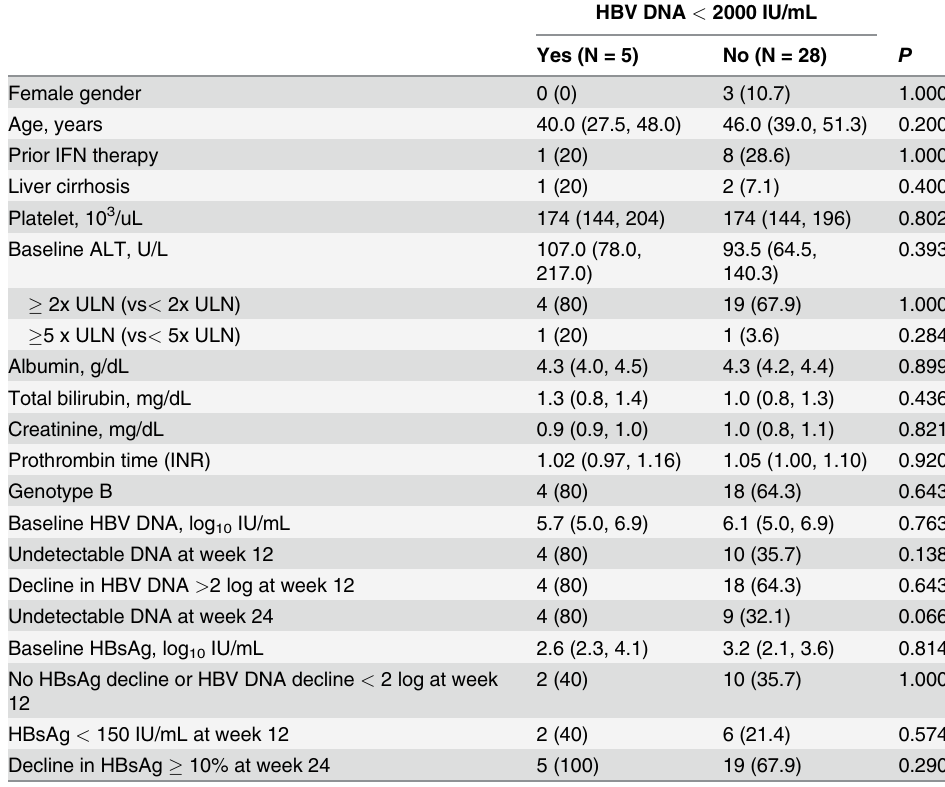
Table 3. Factors associated with HBV DNA < 2000 IU/mL 12 months post-treatment in treatment expe- rienced HBeAg-negative CHB